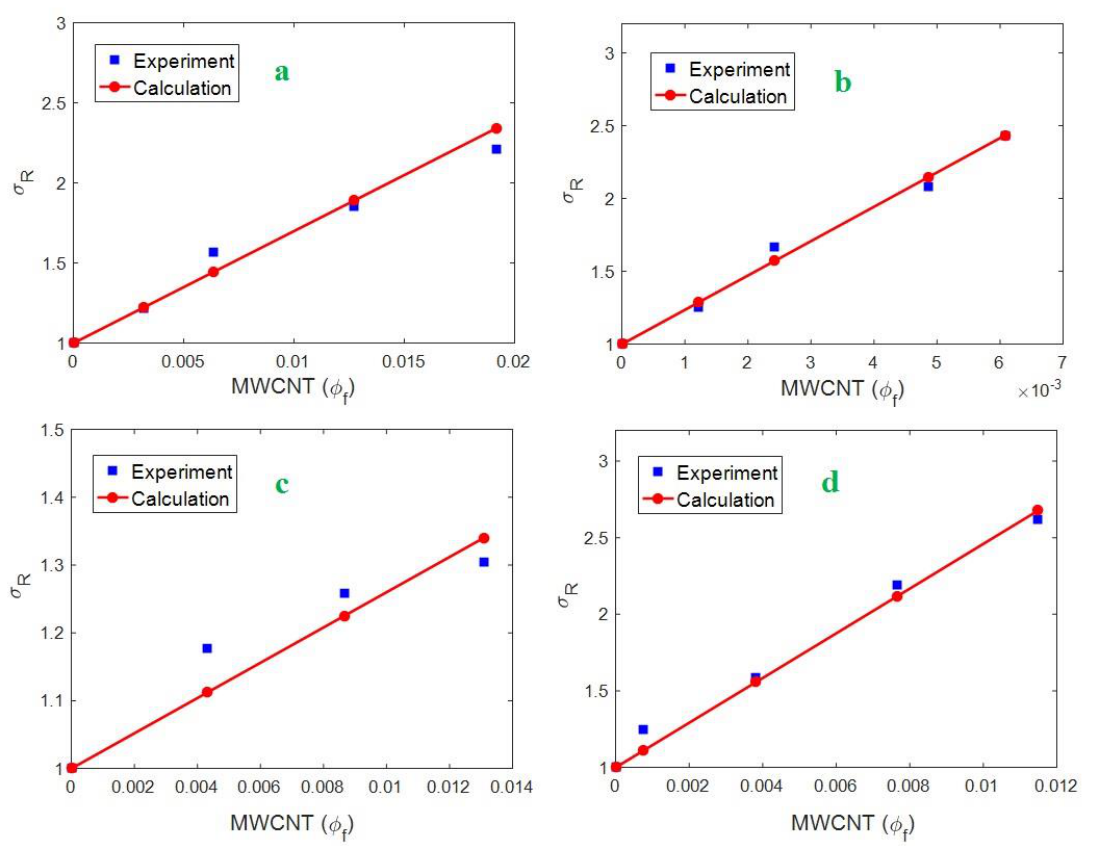
Figure1. TheexperimentalrelativestrengthandthecalculationsofCallister model for( a )PAN / MWCNT, Figure 1. The experimental relative strength and the calculations of Callister model for ( a ) ( b ) PSQ / MWCNT, ( c ) PP / MWCNT and ( d ) chitosan / MWCNT PAN/MWCNT, ( b ) PSQ/MWCNT, ( c ) PP/MWCNT and ( d ) chitosan/MWCNT examples.